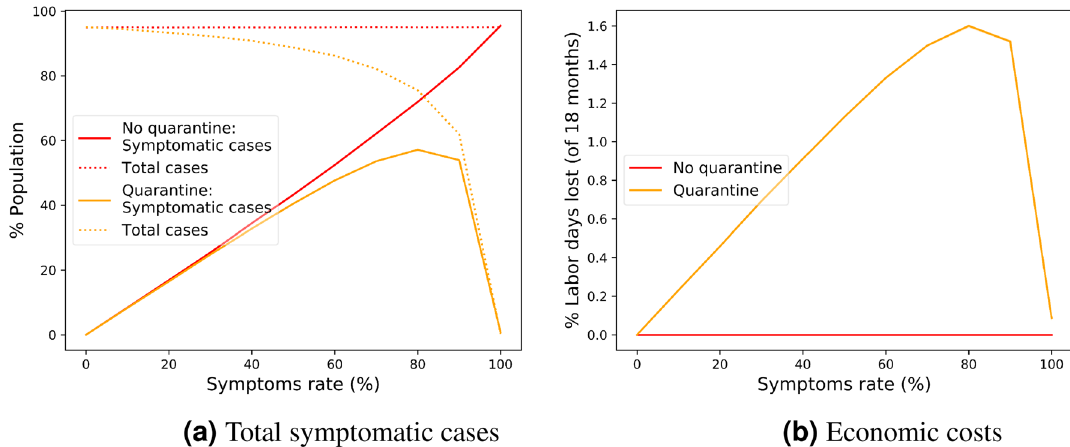
Figure 2. Effect of symptoms rate. (a) The full and dotted lines show the total population percentage of symptomatic and all infected patients, respectively, with and without quarantines, as a function of the symptoms rate. (b) Economic costs with and without quarantines as a function of the symptoms